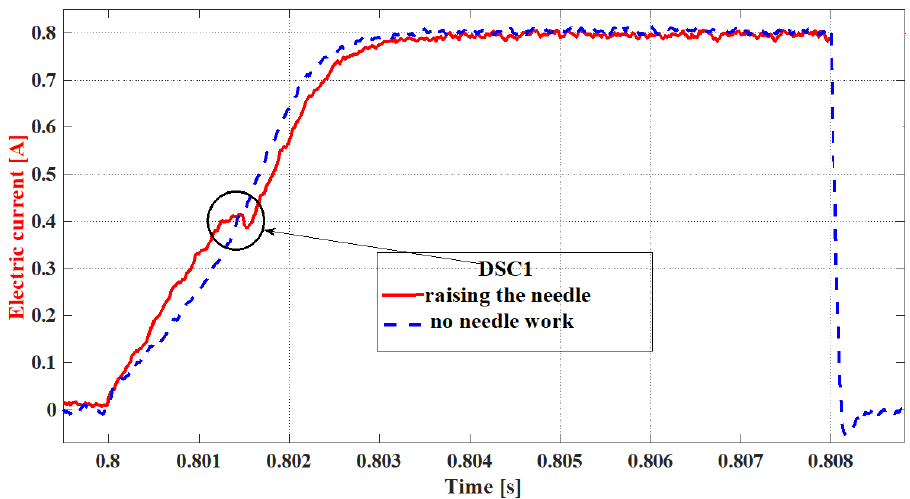
Figure 5. Distribution of magnetic force 𝐹 𝑚 , depending on the electric current intensity I and the needle retraction into the injector core (gap 𝑙 𝑆 ).